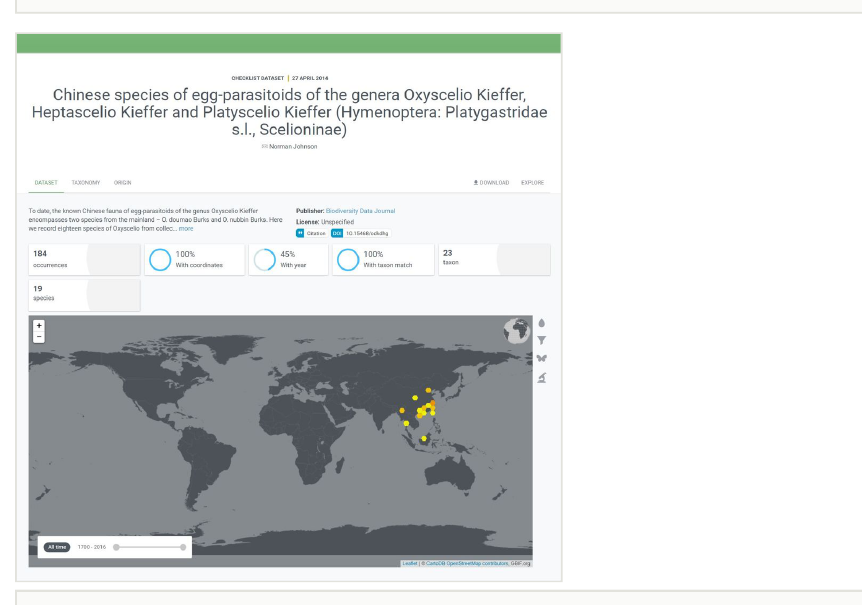
Export of data from articles published in Biodiversity Data Journal. Species occurrences and other structured data tables can be downloaded in CSV format (green arrow); all species occurrences are also available as Darwin Core Archives and are automatically harvested and indexed by GBIF (red box and arrow).